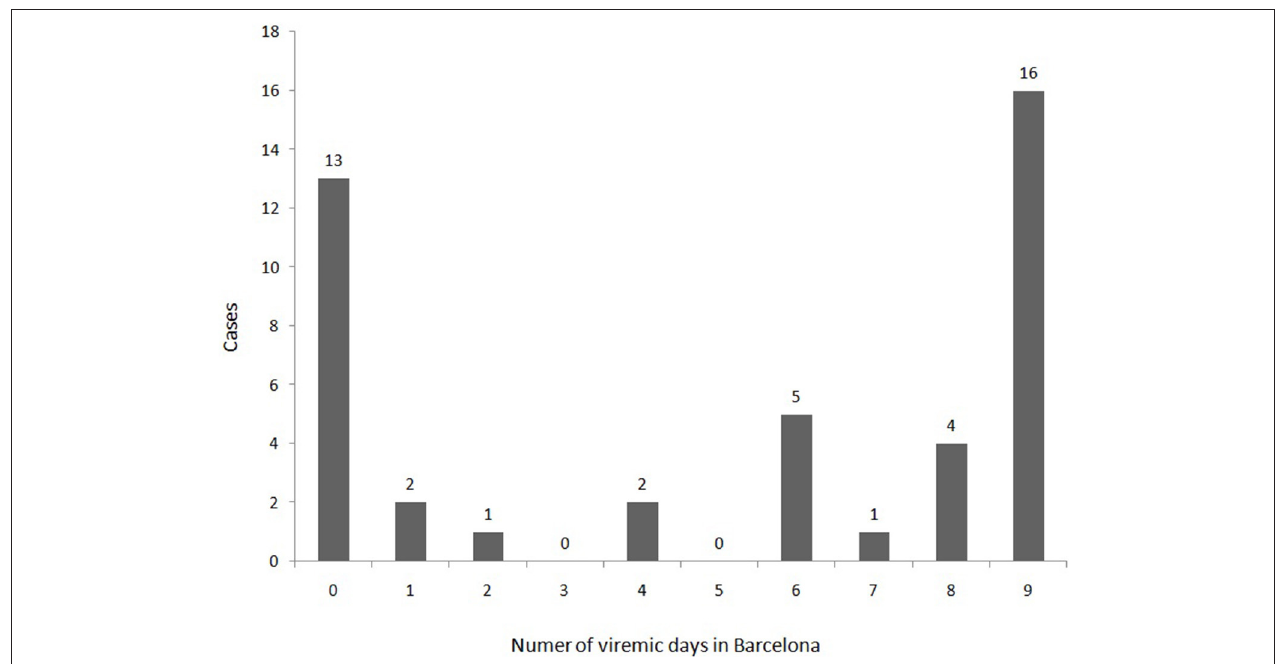
FIGURE 4 | Distribution of the first 44 confirmed cases of Zika virus infection according to the viremic days spent in the city of Barcelona.